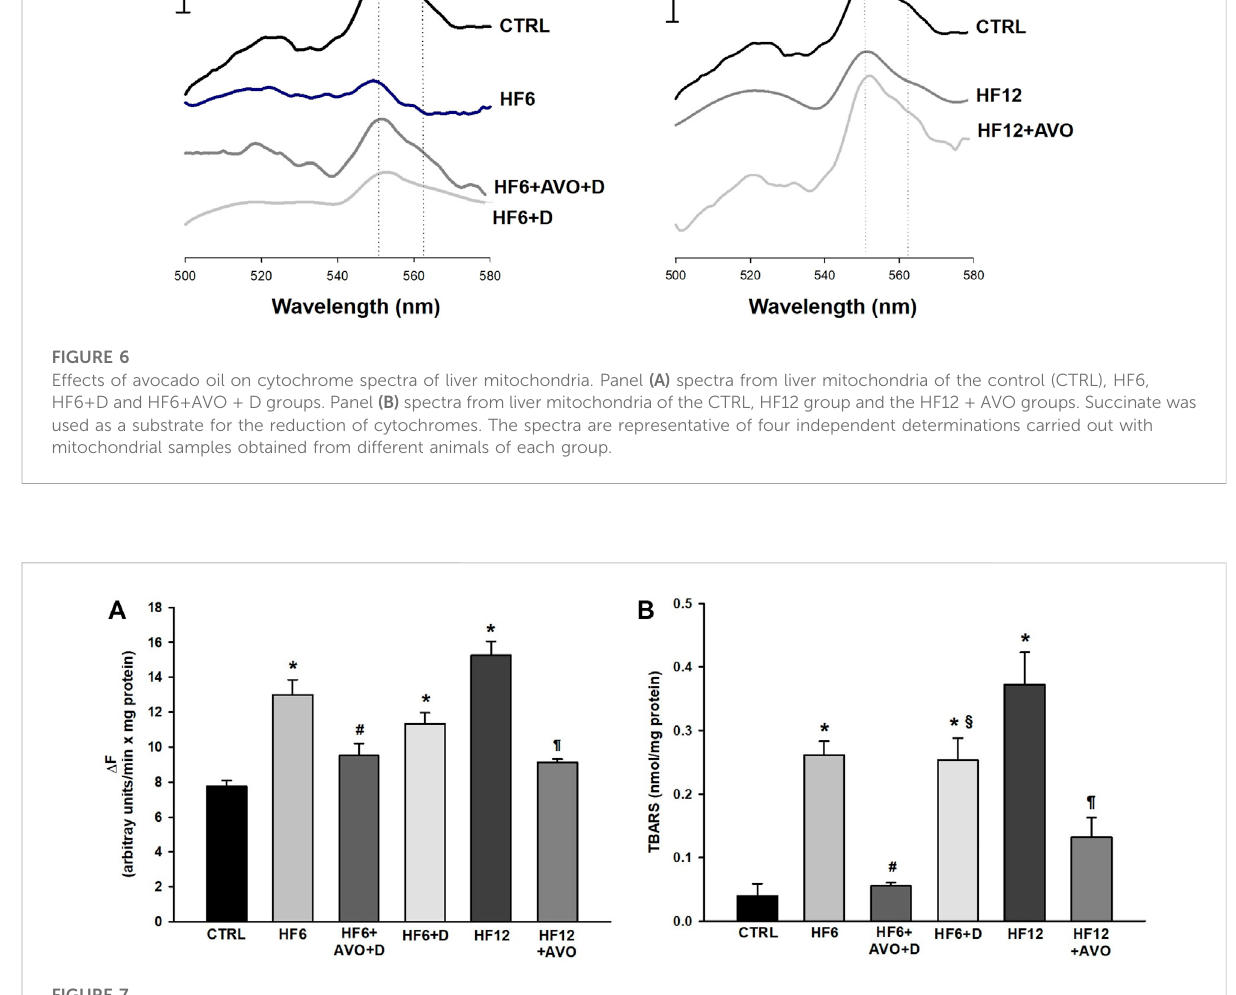
FIGURE 7 EffectsofavocadooilonthelevelsofROS (A) andlipidperoxidation (B)